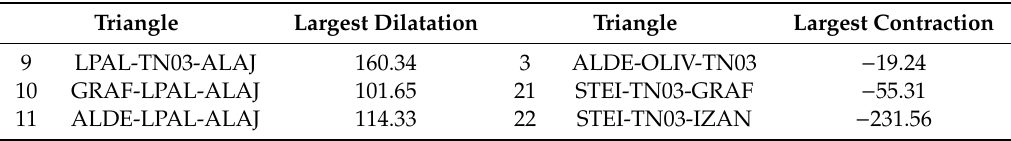
Table 4. Main tectonic change, as derived from the strain analysis, expressed as dilatation or contraction of the triangles (triangle numbers as in Table 2). Units are 10 − 9 .